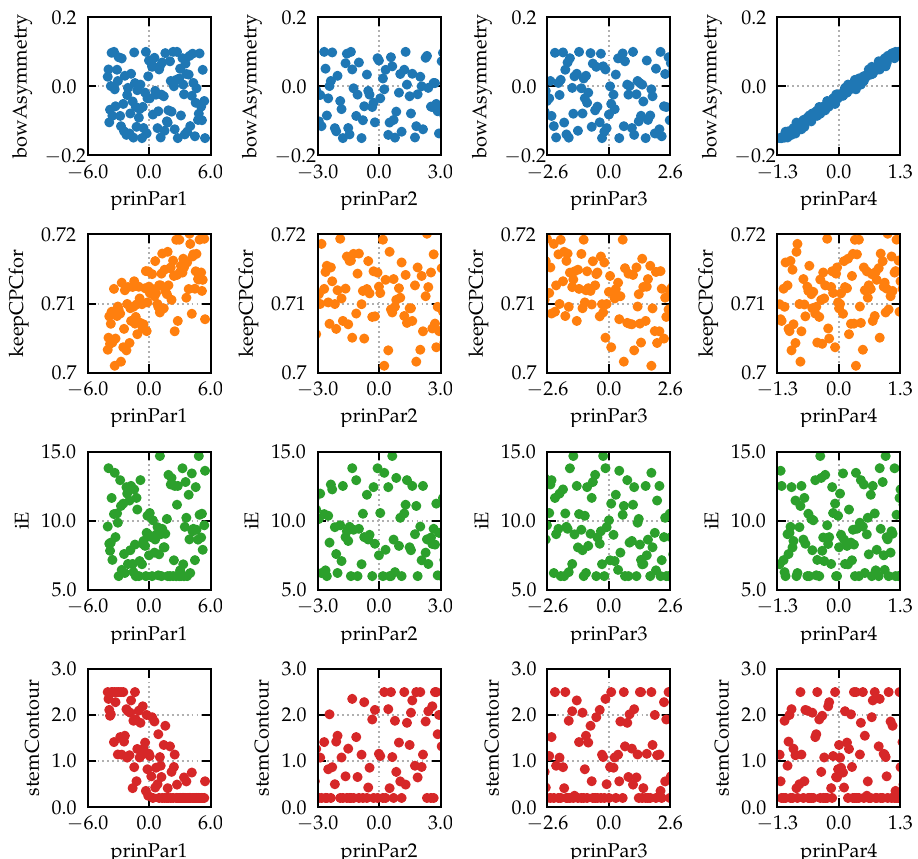
Figure 11. Correlations between several selected CAD variables and the first four principal parame- ters resulting from the